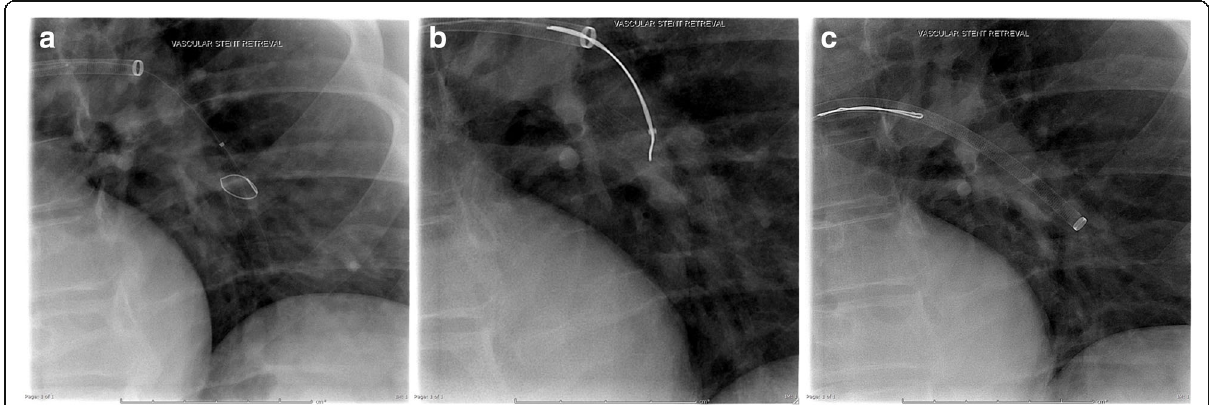
Fig. 5 a and b: Demonstrates the Viabahn stent engaged around the midsection of the stent ( a ) and subsequently ensnared ( b ). c: The ensnared stent is “ sheathed ” over by the braided 12F